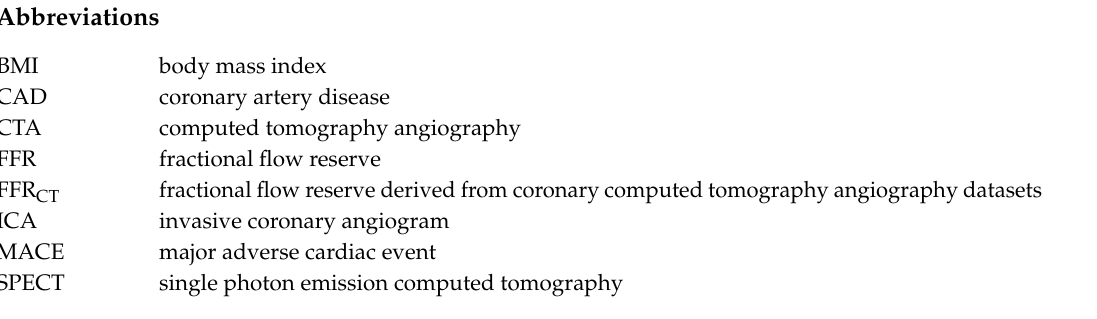
Table S1: ICA Rates by Maximum Stenosis Classification on CTA Stratified by Available FFR CT